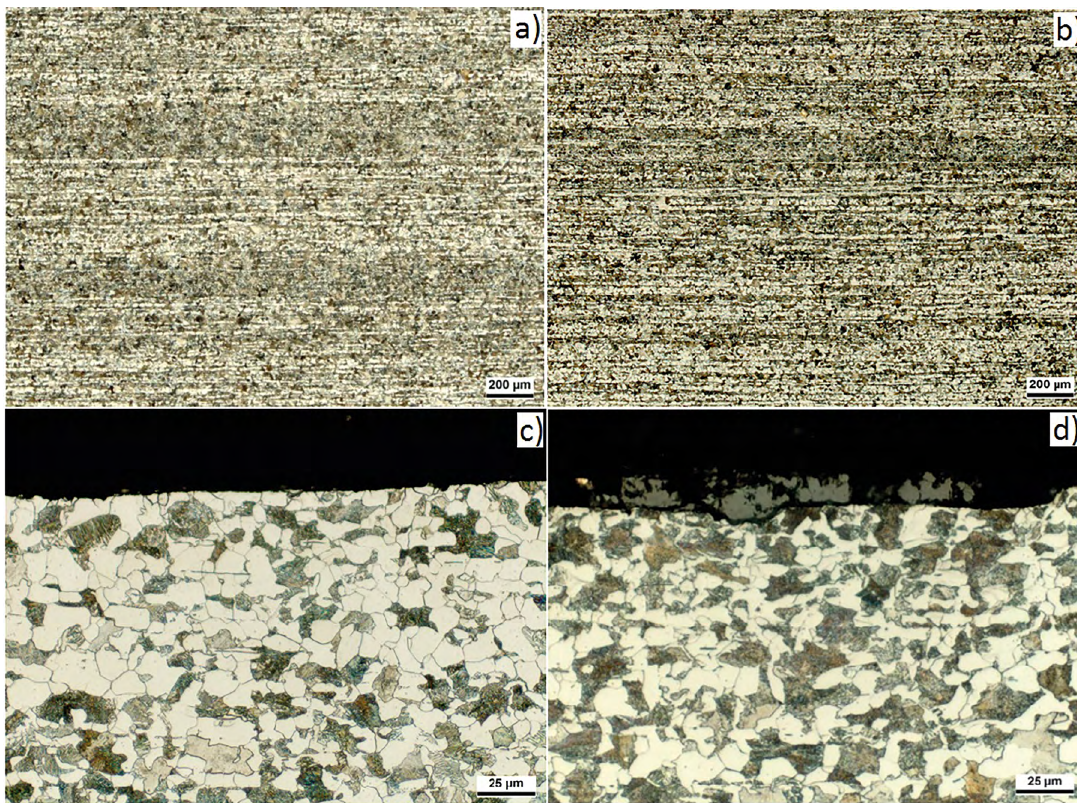
Figure 6. Micrographs over the bar cross section in the center and surface for horizontal pre-straightened samples. In the center (a) of the section 0-180 in the region 1 indicated in Figure 5, (b) of the section 90-270 in the region 2 of the Figure 5 and in surface (c) in 0º side in the region 3 shown in Figure 5 and (d) in 90º side in the region 4 of Figure 5.